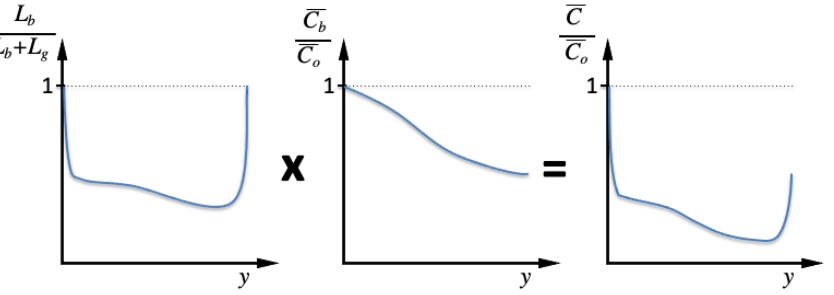
Figure 3. Schematic of the overall average concentration (what the SIMS data provides), which is the product of the grain boundary size to total size ratio and a typical concentration distribution along a straight grain boundary. © (2017) IEEE. Reprinted, with permission, from 2017 IEEE 44th PVSC Proceedings [14].